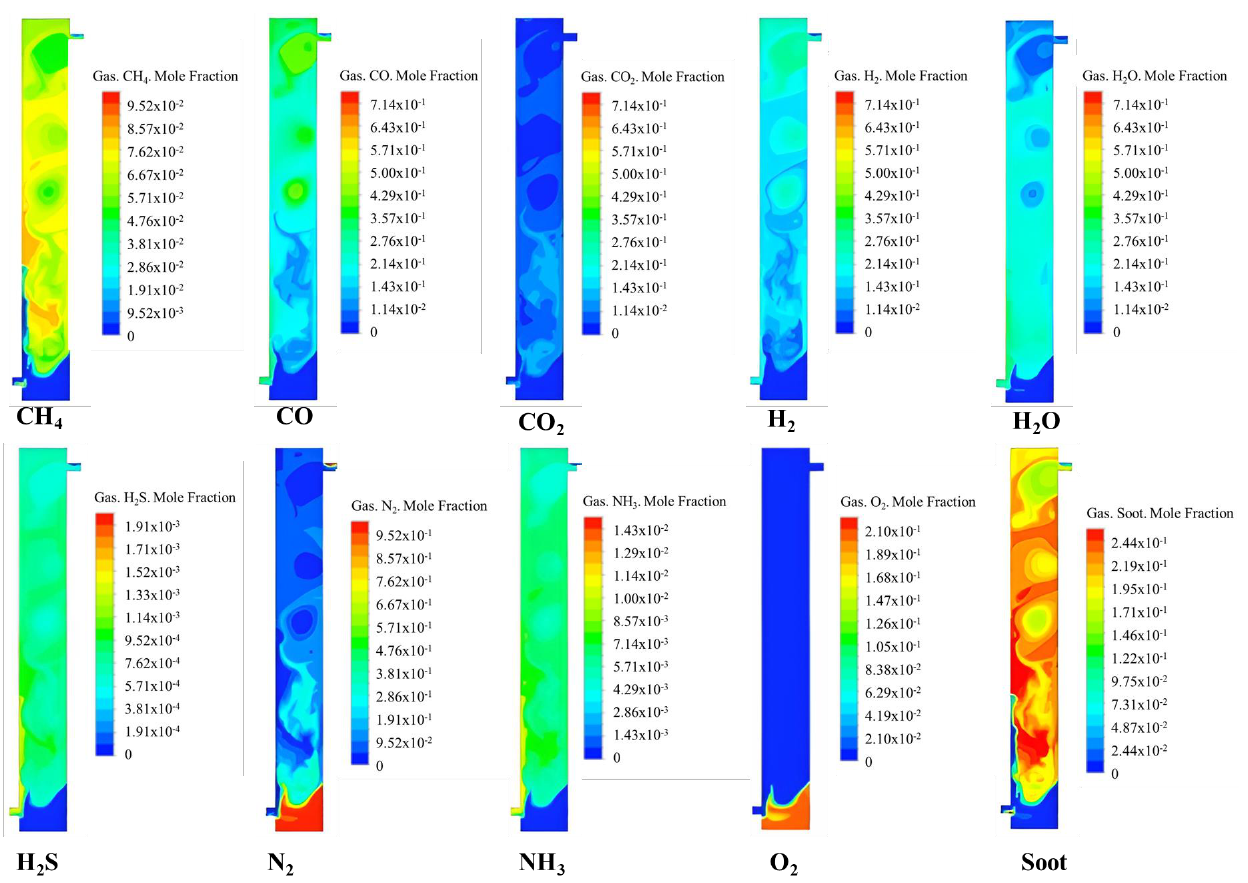
Figure 6. Mole fraction distributions of different gases in the middle section of the gasifier (ER = 0.2; T = 1000 K).